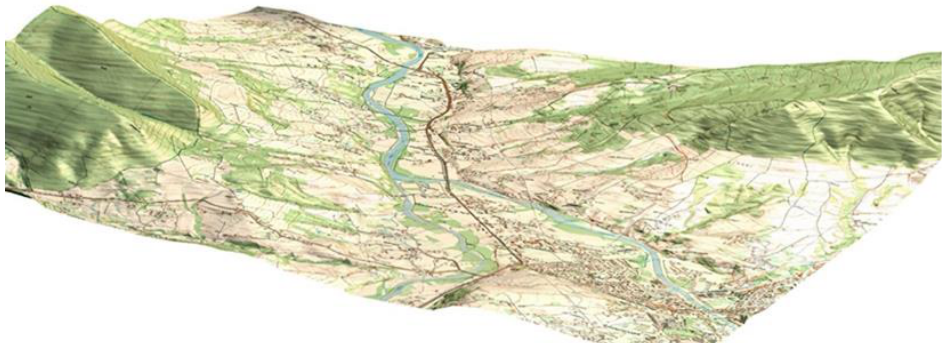
Figure 19. Textured DTM model view from the side of the city of Mszana Dolna .